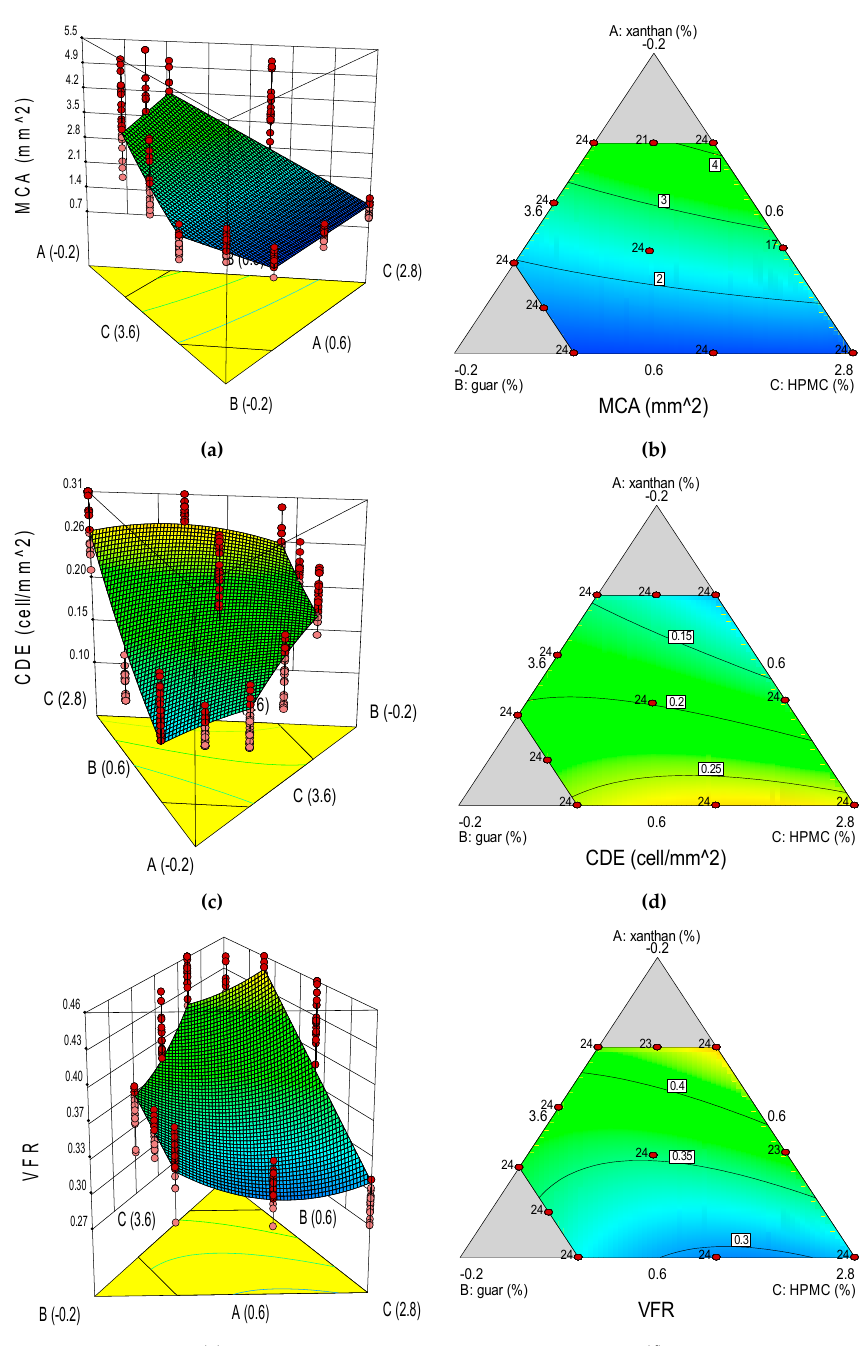
Figure 5. Three-dimensional surface (3-D, left) and two-dimensional contour (2-D, right) plots showing the effect of xanthan gum (A), guar gum (B) and HPMC (C) on the gluten-free crumb grain features of mean cell area (MCA, mm 2 ); mean cell density (CDE, cells / mm 2 ); void fraction (VFR, dimensionless), were: ( a ), MCA 3-D; ( b ), MCA 2-D; ( c ), CDE 3-D; ( d ), CDE 2-D; ( e ), VFR 3-D; and ( f ), VFR